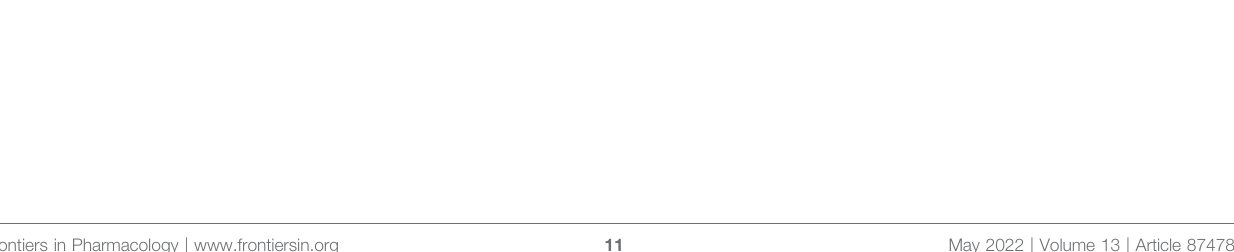
Frontiers in Pharmacology |